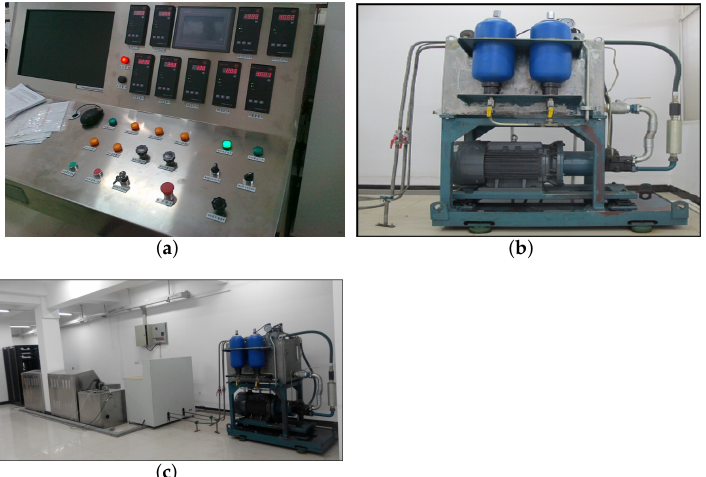
Figure 9. Semi-physical simulation platform of anti-skid braking system: ( a ) electrical console; ( b ) hydraulic pump and piping; ( c ) overall